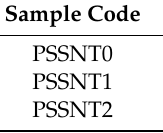
Table 2. Full width at half maximum (FWHM) for pure polystyrene (PS) and nanocomposite films. Sample